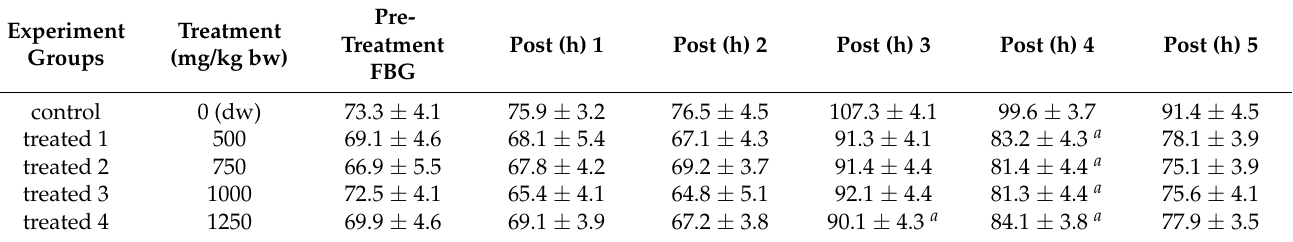
Table 4. Effect of graded dose of t. dioica leaves aqueous extract on BGL during GTT of normoglycemic rats (mean ± standard deviation) for pre- and post-